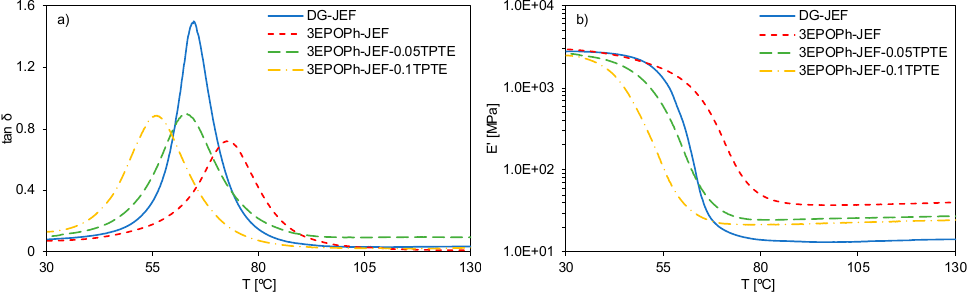
Figure 6. Tan δ ( a ) and E’ ( b ) curves of the materials prepared. Table 4. Thermomechanical data of the materials studied obtained by